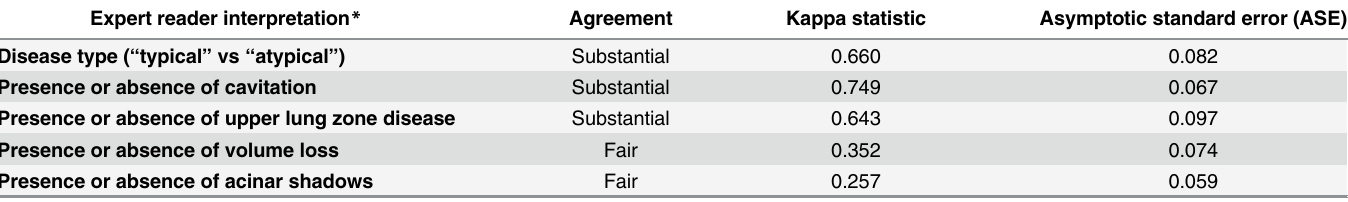
Table 1. Expert inter-reader variability of chest radiographic